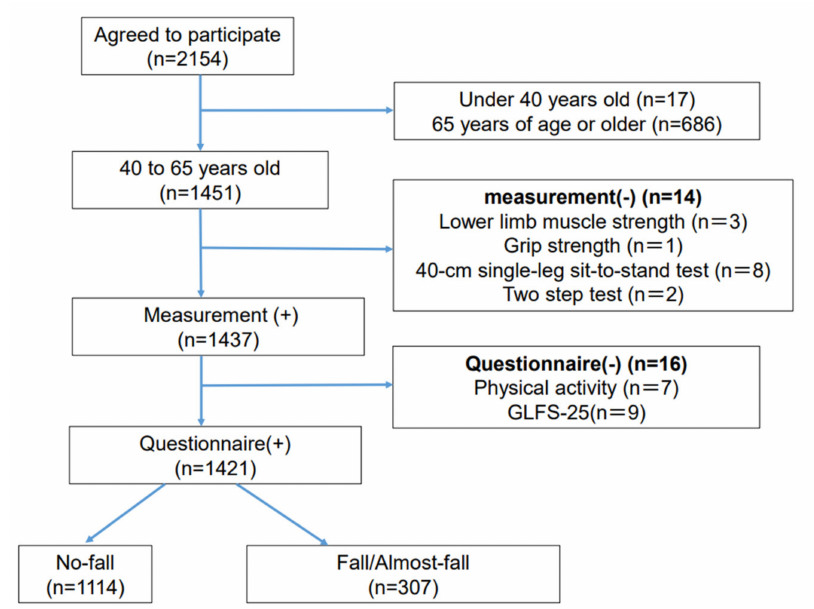
Figure 1. Flowchart detailing the enrollment process for the